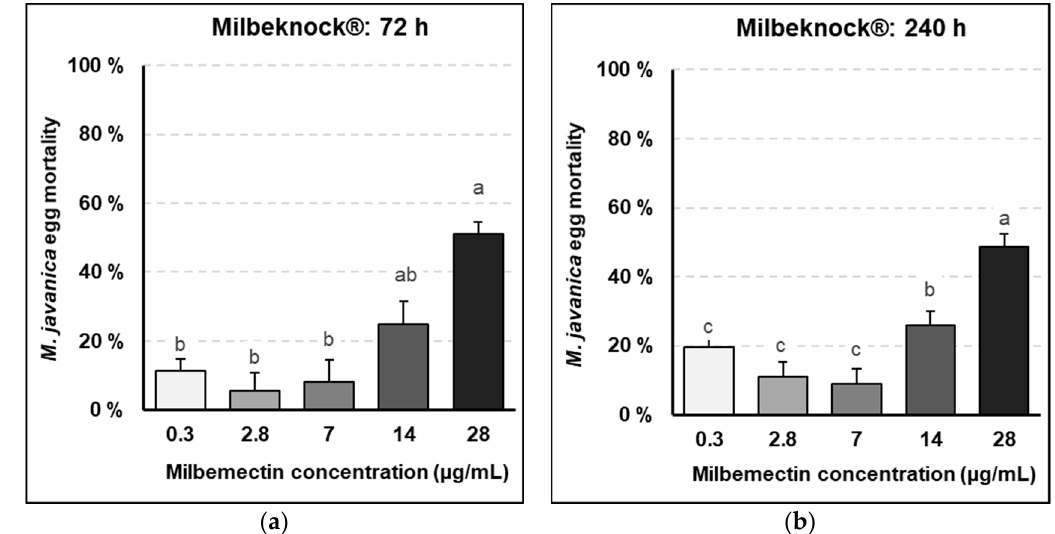
Figure 2. Meloidogyne javanica egg mortality due to progressively higher concentrations of Milbeknock ® . ( a ) After 72-h exposure; ( b ) after 240-h exposure to Milbeknock ® . Data are mean of eight replicates. Error bars indicate the standard error of the means. Bars with the same letter do not di ff er significantly by the HSD Tukey test ( p < 0.05).